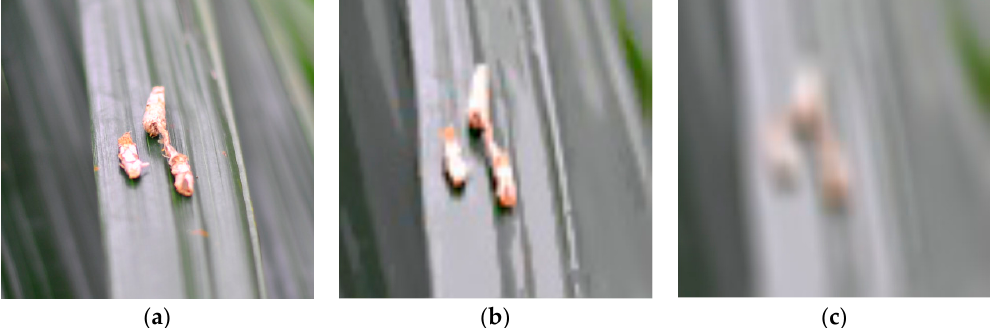
Figure 2. Morphological image processing using: ( a ) Original RGB image, ( b ) Polarized image after Pyramid mean shift filter, and ( c ) Gaussian blur filter.